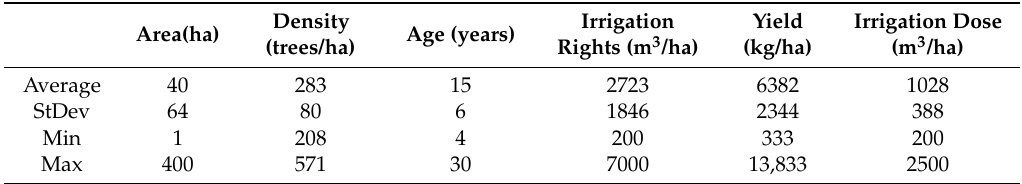
Table 1. Basic descriptive